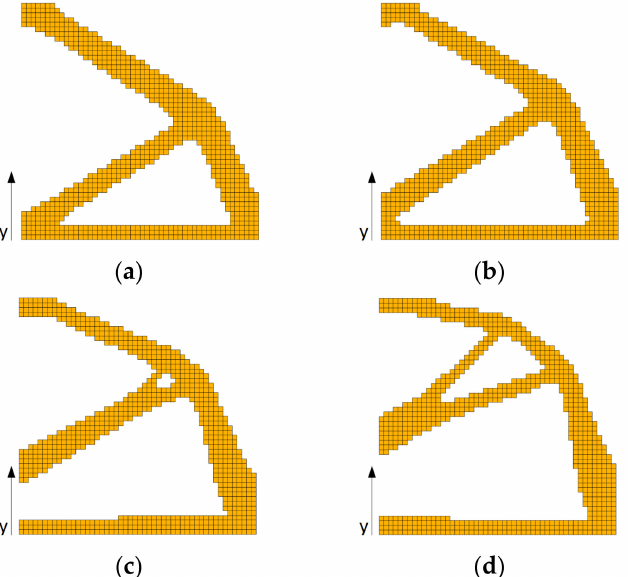
Figure 8. Final topologies obtained for square structure for the FGM-RAMP material interpolation scheme, y -direction of material gradation: ( a ) β = − 0.02, minimal compliance: 4.744 Nm; ( b ) β = − 0.04, minimal compliance: 9.134 Nm; ( c ) β = − 0.06, minimal compliance: 17.712 Nm; ( d ) β = − 0.08, minimal compliance: 33.408 Nm.